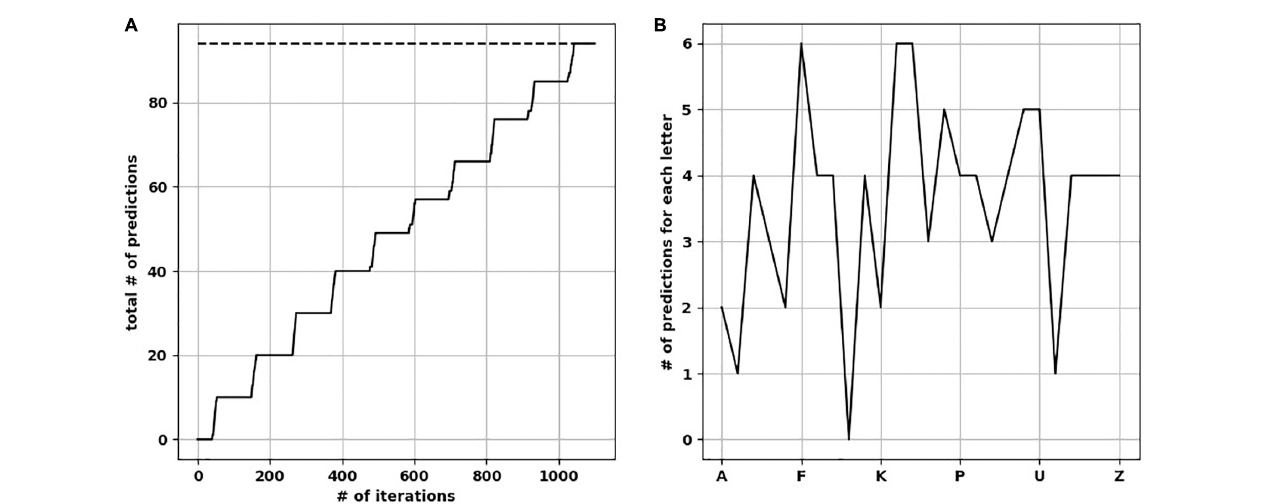
FIGURE3 The network learned and reached the number of ideal predictions. (A) Over 1,100 iterations, the network progressively made predictions approaching ideal predictions (dotted line). (B) Number of predictions when the network was presented by each upper-case letter, resulting in a “prediction